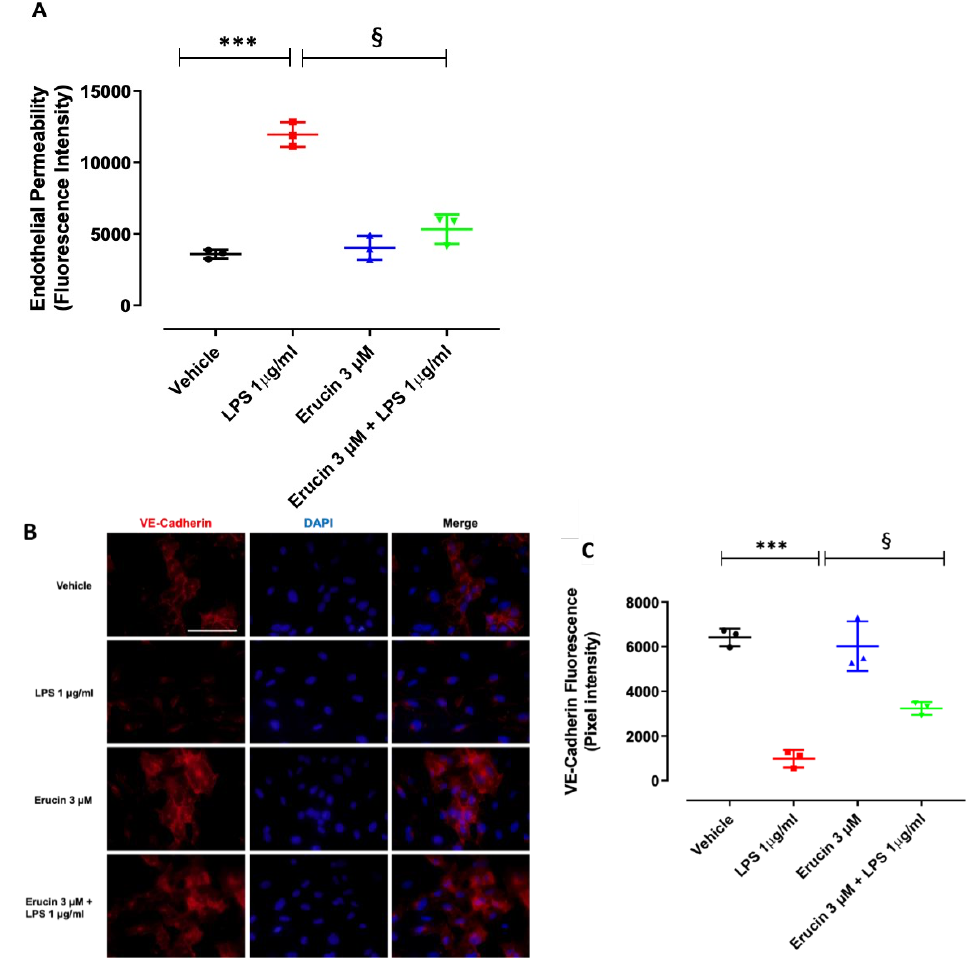
Figure 3. Effect of erucin on endothelial hyperpermeability induced by LPS. ( A ) Paracellular flux on HUVECs pre-treated with erucin (3 µM, 1 h) and then with LPS (1 µg/mL, 1 h). FITC-dextran transport in the lower compartment was measured at the end of LPS stimulation. ( B ) Integrity of cell – cell contacts evaluated by immunofluorescence analysis of VE-Cadherin in HUVEC monolay- ers pre-treated with erucin (3 µM, 1 h) and then with LPS (1 µg/mL, 1 h). Images were obtained by confocal microscope. Scale bar — 50 µm. ( C ) Fluorescence intensity was measured on four images per slide by using Fiji software. Results are shown as mean ± SD. *** p < 0.001 vs. vehicle; § p < 0.05 vs. LPS 1 µg/mL. 2.4. Preventive Effects of Erucin against Cell Viability Reduction and Intracellular ROS Increase in HUVECs Challenged with LPS Endothelial cells were exposed to LPS for longer times of incubation (6 and 24 h), which are compatible with biochemical, molecular and functional responses related to in- flammation (6 h) and mimic a persistent and progressive inflammatory state (24 h). The treatment of HUVECs with LPS 1 µg/mL significantly decreased cell viability (% of cell viability vs. vehicle: 78.46 ± 1.28 after 6 h and 83.49 ± 2.80 after 24 h). Only the pre-incubation of the highest concentration of erucin (3 µM) led to a signif- icant, although modest, prevention of such decrease (% cell viability vs. vehicle was 82.79 ± 2.62 for 0.3 µM, 81.75 ± 2.56 for 1 µM and 89.54 ± 3.18 for 3 µM after 6 h, and 78.45 ± 2.65 for 0.3 µM, 85.61 ± 3.30 for 1 µM and 94.10 ± 2.29 for 3 µM after 24 h) (Figures 4A,B). In addition, LPS induced a significant increase in intracellular ROS production (% ROS vs. vehicle: 120.42 ± 3.32 after 6 h and 114.28 ± 2.64 after 24 h). The pre-incubation of increasing